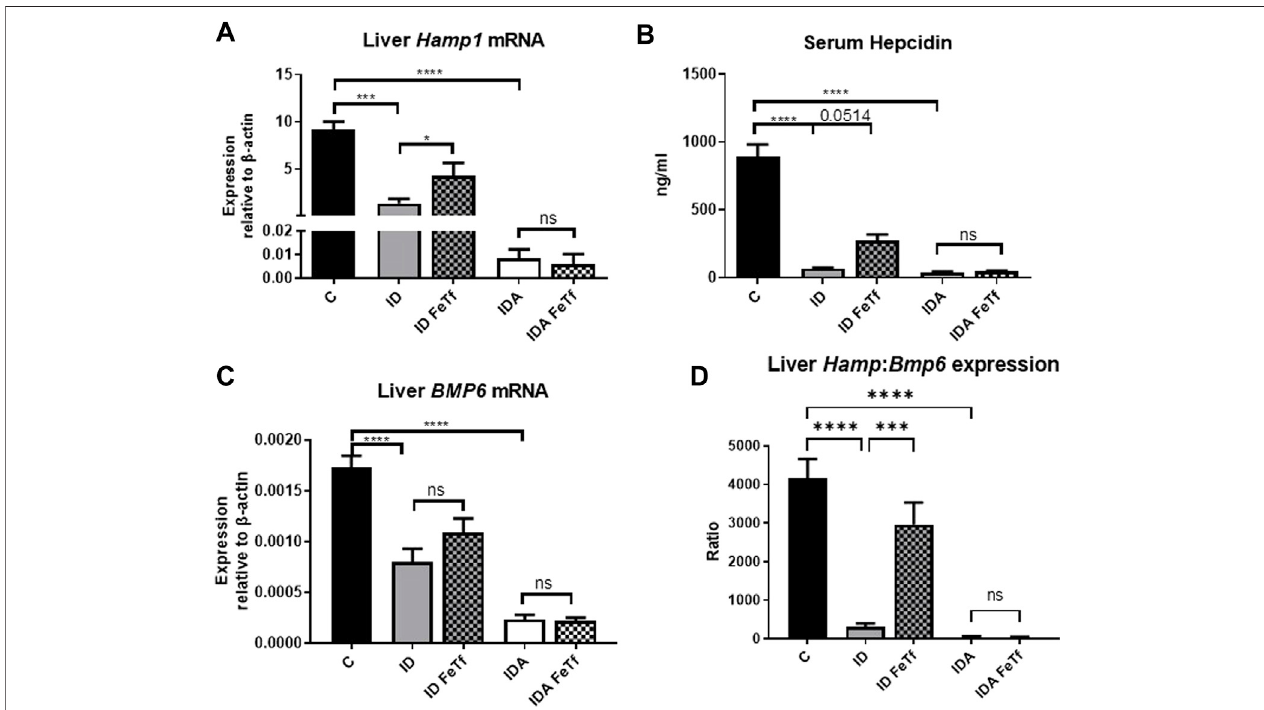
FIGURE 7 | Exogenous transferrin increases hepatic hepcidin expression in mice with iron de fi ciency. ID and IDA mice were treated with carrier or holotransferrin. (A) Liver Hamp1 mRNA, (B) serumhepcidinand (C) liver Bmp6 mRNAweremeasured. (D) Liver Hamp1 mRNAwasindexedtoliver Bmp6 mRNA.qPCRassays:control mice n =10 – 13,forIDcohorts n =7 – 14andforIDAcohorts n =6-7micepergroup.Serumassay:forcontrolmice n =10,forIDcohorts n =3andforIDAcohorts n =3-4 micepergroup.Controlmicefedastandard250 ppmFedietareincludedforreference.ppm,partspermillion;datarepresentedasmean(SEM).*, p < 0.05;***, p < 0.005; ****, p < 0.001; ns, non-signi fi